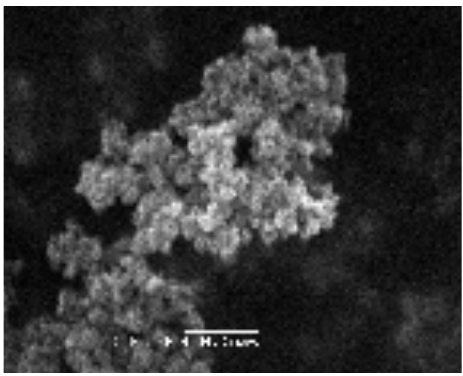
Figure 5. The accumulative release rate of As